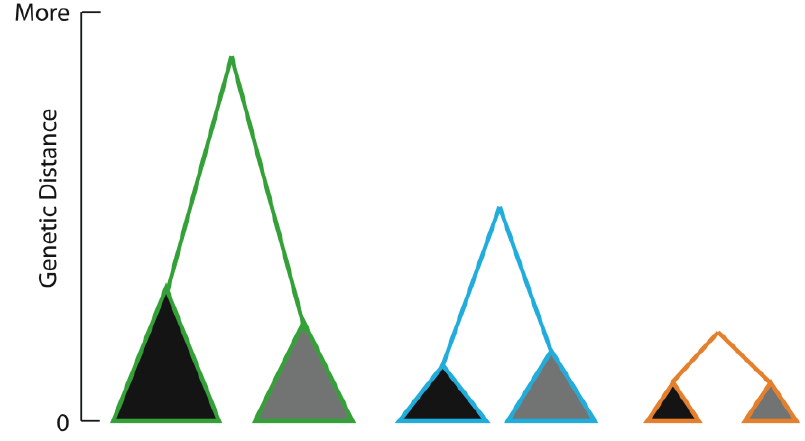
Figure 6. Three hypothetical taxa (green, blue, gold), each with populations in the same two areas (grey, black). Coalescent depth may differ among them, but this might be due to population size, gene/taxon specific mutation rate, lineage sorting effects or timing of historical event. Distinguishing between events requires clear statements of assumptions made in dating of nodes, to allow testing among alternative drivers of population partitioning if circularity is to be avoided